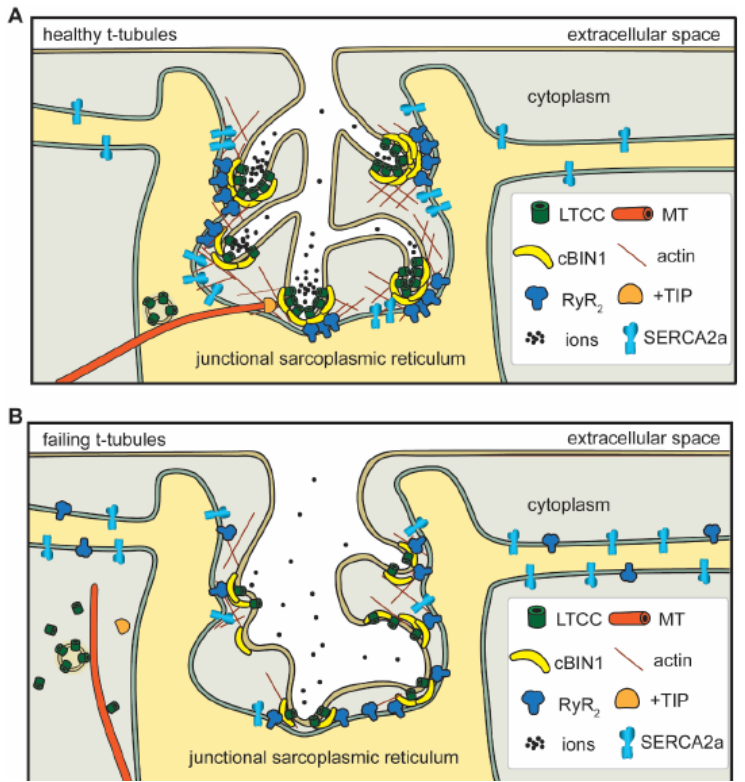
Figure 1. In healthy cardiomyocytes ( A ), t-tubule cBIN1-microdomains regulate intracellular calcium handling through: (1) facilitating forward delivery of L-type calcium channels (LTCCs) via plus-end tracking protein (+TIP) tipped microtubules (MT); (2) clustering LTCCs that are already delivered to t-tubule surface; (3) recruiting ryanodine receptors (RyRs) at the junctional sarcoplasmic reticulum (jSR) for effective dyad formation; (4) organizing a subpopulation of SERCA2a near the jSR; and (5) creating an extracellular slow ion diffusion zone. All of these functions are disrupted in failing cardiomyocytes ( B